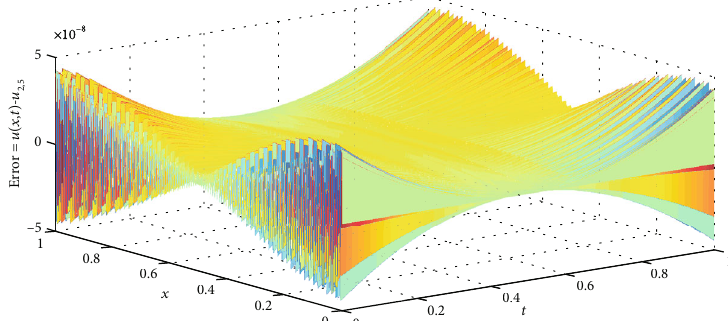
, t Þ for Example 1. 2,5 ð x